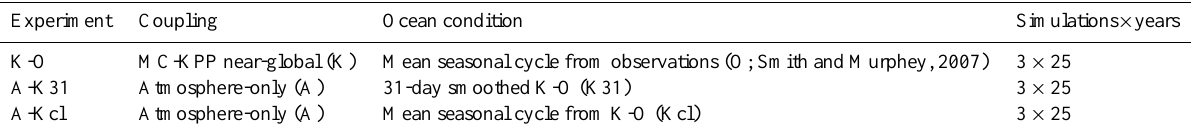
Table 1. Summary of simulations carried out in the current study. Experiment